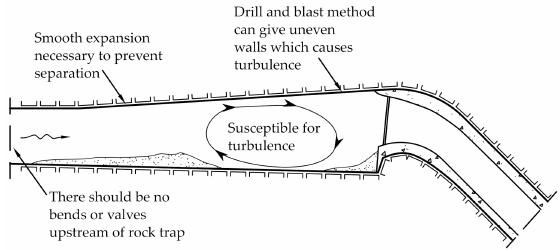
Figure 6. Drawbacks of open rock